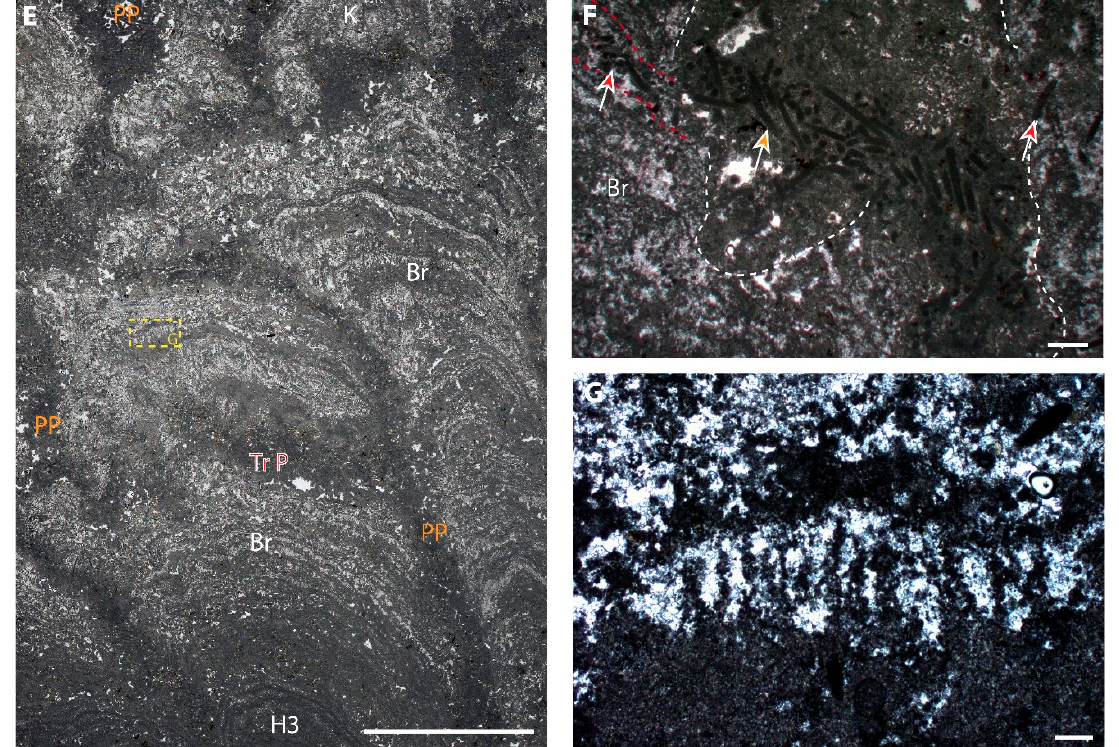
Figure 13. Illustration of Microbialite Association 2b in Las Negras, DS4 (see also Figures 3 and 5C). ( E ) and ( F ) are scans of a thin section of the base of the succession, as indicated in ( A ) and ( C ), while ( G ) is a polarizing microscope photograph in plane polarized light. ( A ) The base of the microbialite bed, displaying a progressive vertical change from small, laterally links hemispheroids (H3) to branches which are subsequently included in the base of a giant thrombolitic column (Co), see ( B , C ). The inter ‐ branch space was filled with a pellet packstone (orange arrows), see ( F ). ( B ) Superposition of two generations of giant thrombolitic columns (Co; pink lines). In the upper bed, columns are embedded in cross ‐ bedded pellet packstones (PP). The person for scale is 1.8 m tall. ( C ) Synthetic cross ‐ section of DS4 in Las Negras, showing the vertical evolution of microbialites and associated deposits. ( D ) Floatstone with pellets and entire mollusks (Bi = bivalves; Ga = gastropods) filling the upper part of the space between thrombolitic columns. ( E ) Thin section of the transition between small hemispheroids (H3) and branches, see ( A ) for the location of the thin section. The inter ‐ branch space is filled with a pellet packstone (PP). The branches display peloidal laminae alternating with trapped pellets and fine volcanoclastics laminae (TrP), forming a laminated peloidal microfabric (Figure 4). ( F ) Close ‐ up view of ( E ), at the interface between the branch and the pellet packstone. A lamina made of trapped pellets (red arrow) can be observed inside the branch (red dotted line). The porosity of the pellet packstone is partly preserved, while the microbialite porosity is almost entirely cemented by low magnesian calcite (LMC), which may be due to early cementation. The scale bar is 500 μ m. ( G ) Close ‐ up view inside a branch ( E ), showing micro ‐ columns made of dolomite peloids, probably precipitated on filamentous cyanobacteria sheaths (see Table 2). The scale bar is 200 μ m. Two paleosalinity ranges were inferred for MA2a and MA2b, based on the biotic associations